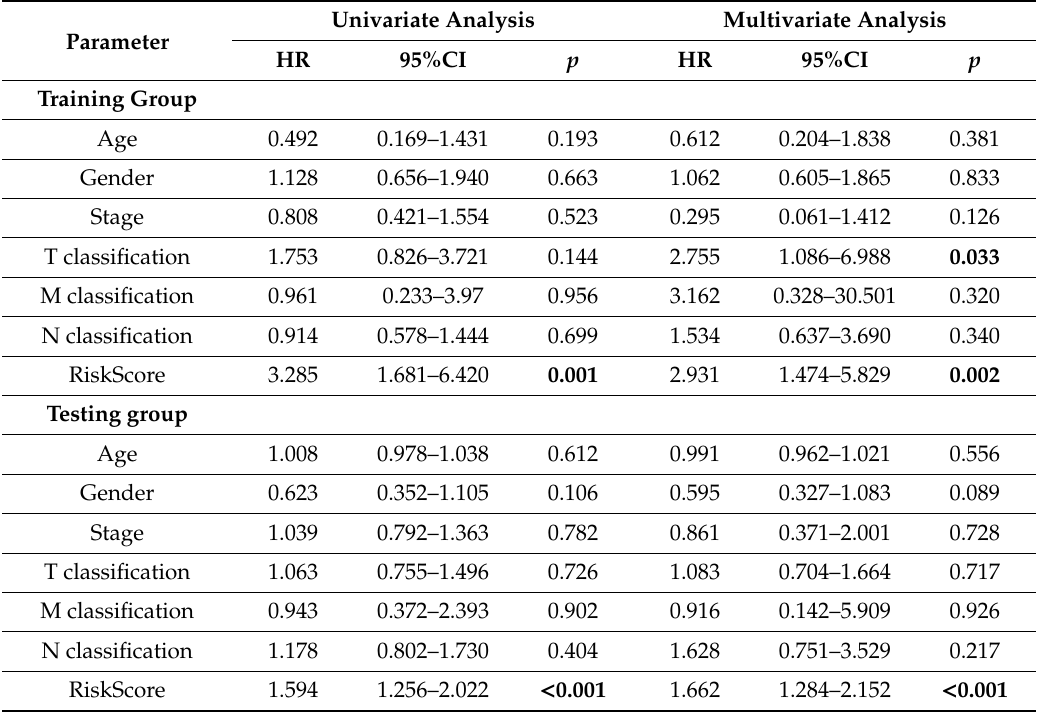
Table 4. Univariate and multivariate Cox regression analysis for risk score on overall survival of patients with